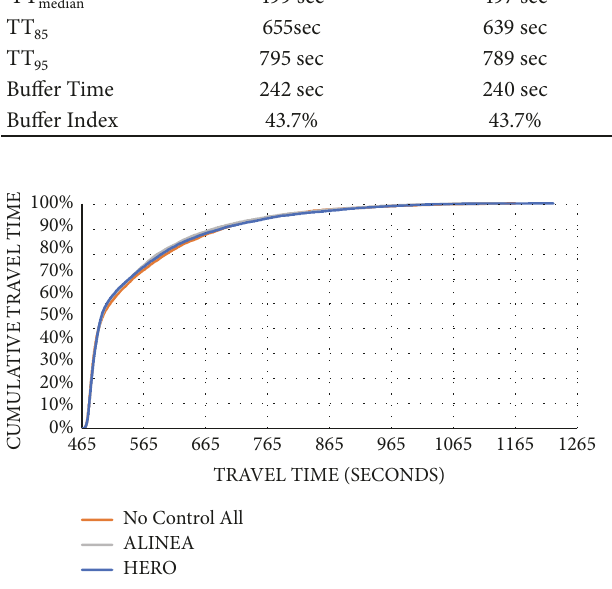
Figure 5: Cumulative travel time distribution of the facility under no control, ALINEA, and HERO ramp